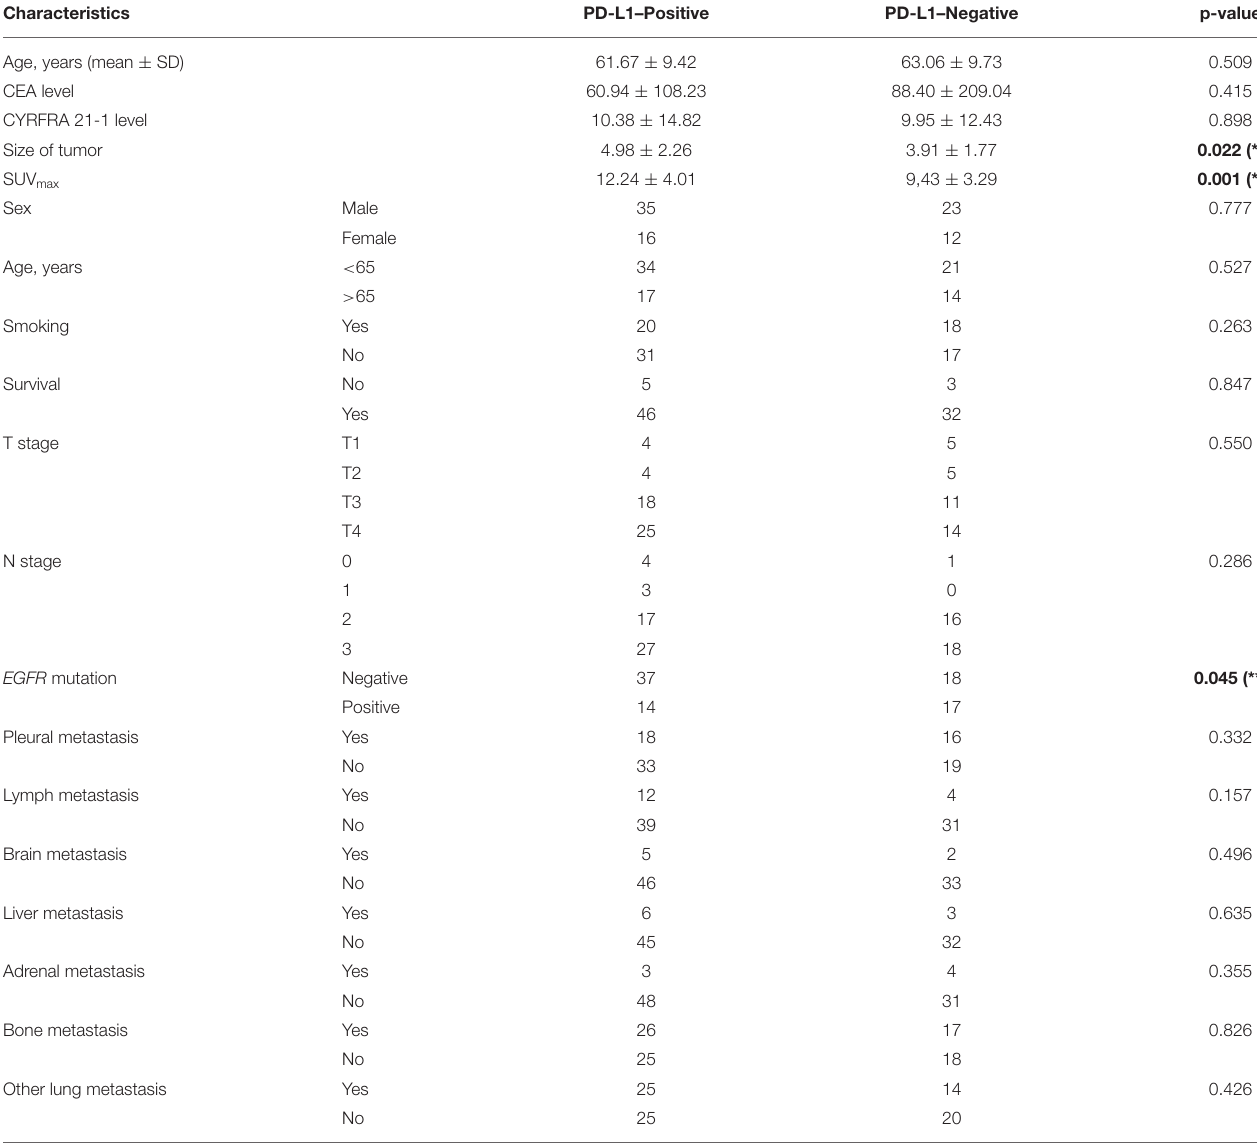
TABLE 3 | Comparisons between patient characteristics and PD-L1 expression.